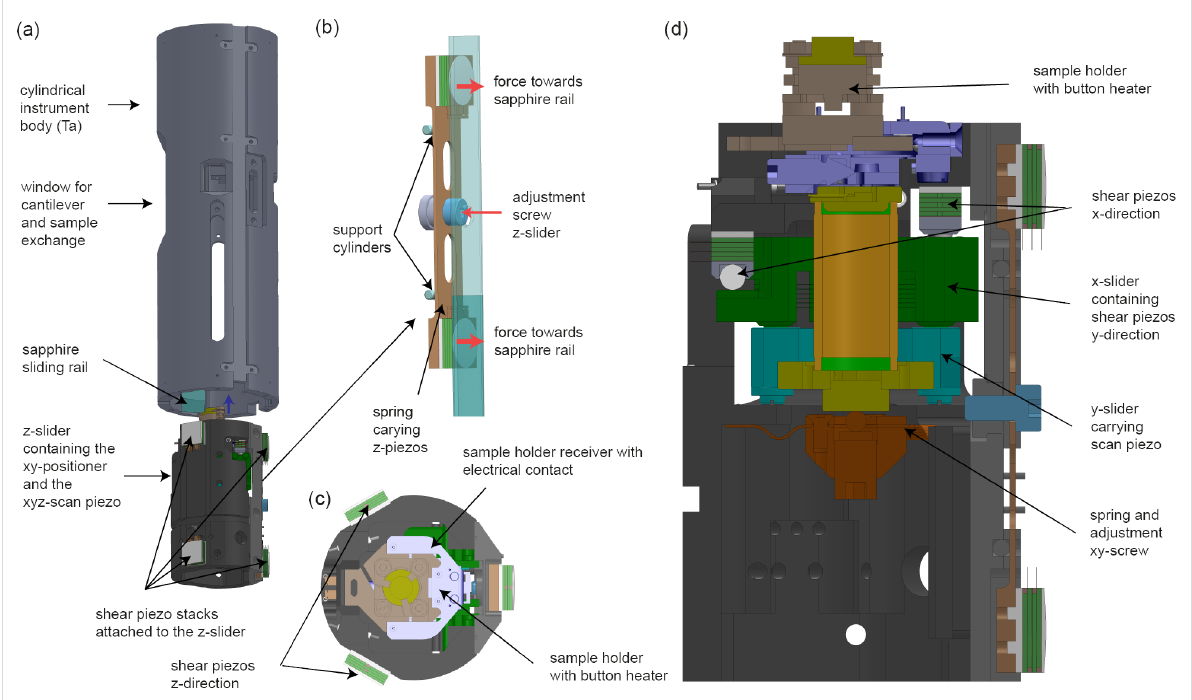
Figure 4: CAD drawings of the cylindrical body tube (a) and the leaf spring (b) carrying two of the total of six shear piezo stacks. The top and the cross-sectional views of the z-slider unit are shown in panels (c) and (d), respectively. The z-positioning unit also contains the xy-positioning unit and the xyz-scan tube carrying the sample holder receiver with the sample